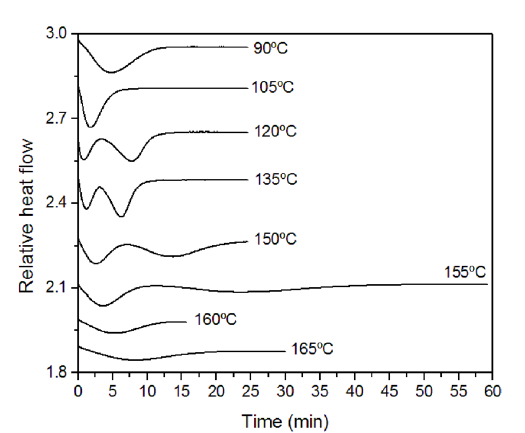
Figure 4. DSC curves of isothermal crystallization at different temperatures for